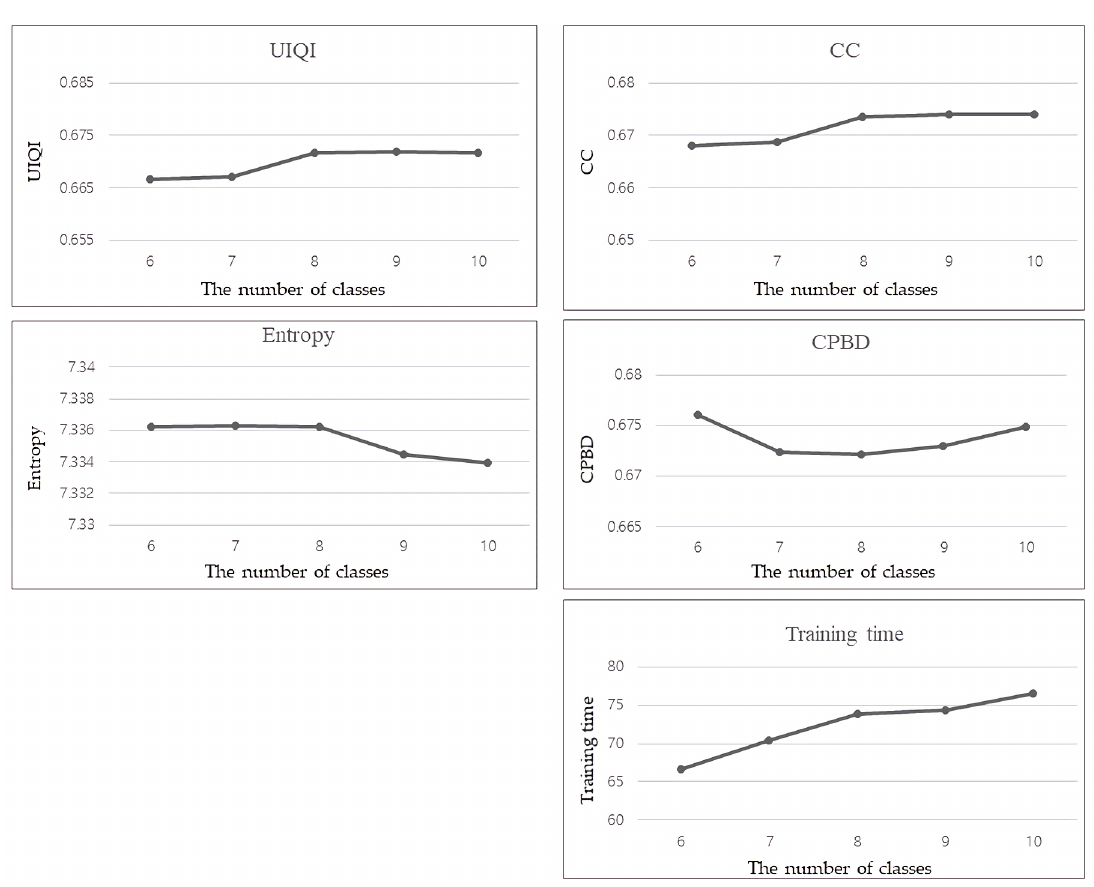
Figure 6. Statistical evaluation according to number of classes for Site 1. UIQI, universal image quality index. CC, correlation coefficient. CPBD, cumulative probability of blur